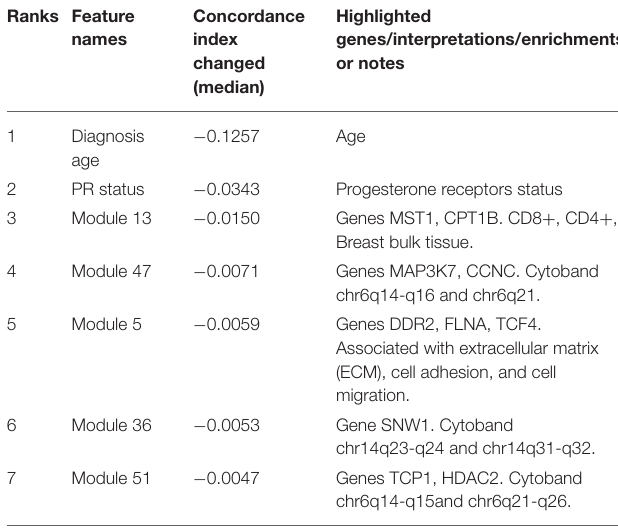
TABLE 3 | Top features that reduced the concordance index, including two demographical and clinical features, and five mRNA-seq co-expression modules (eigengene matrices as inputs to the